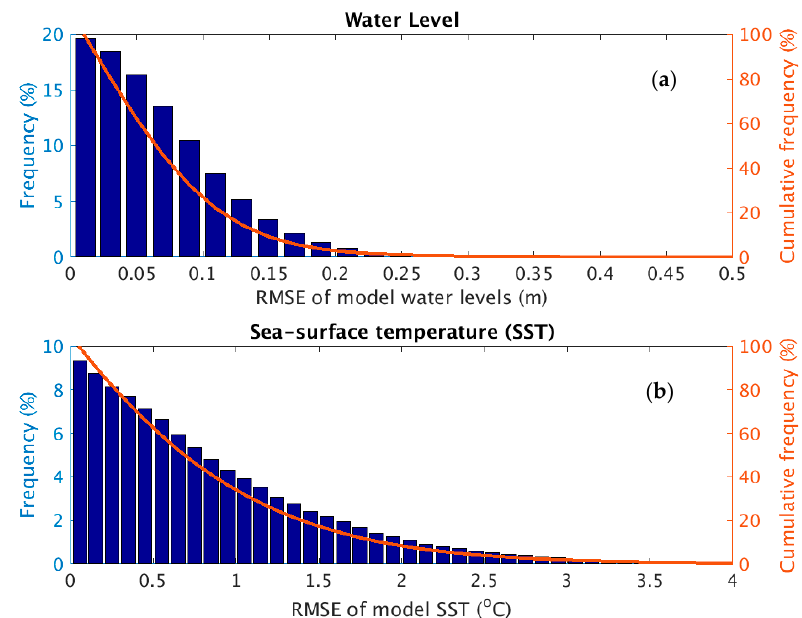
Figure 21. Frequency and cumulative frequency of the model RMSE for ( a ) the water levels and ( b ) the sea-surface temperatures.